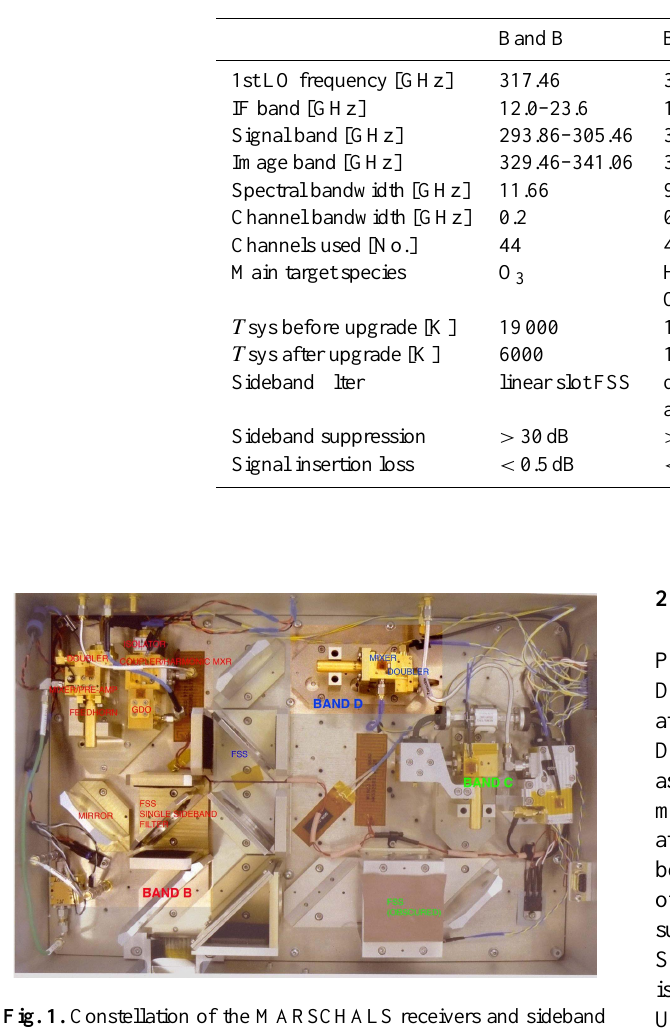
Table 1. Frequency coverage and spectral performance of the three MARSCHALS spectral bands. The signal band dimensions reported in the table refer to the original instrument configuration.